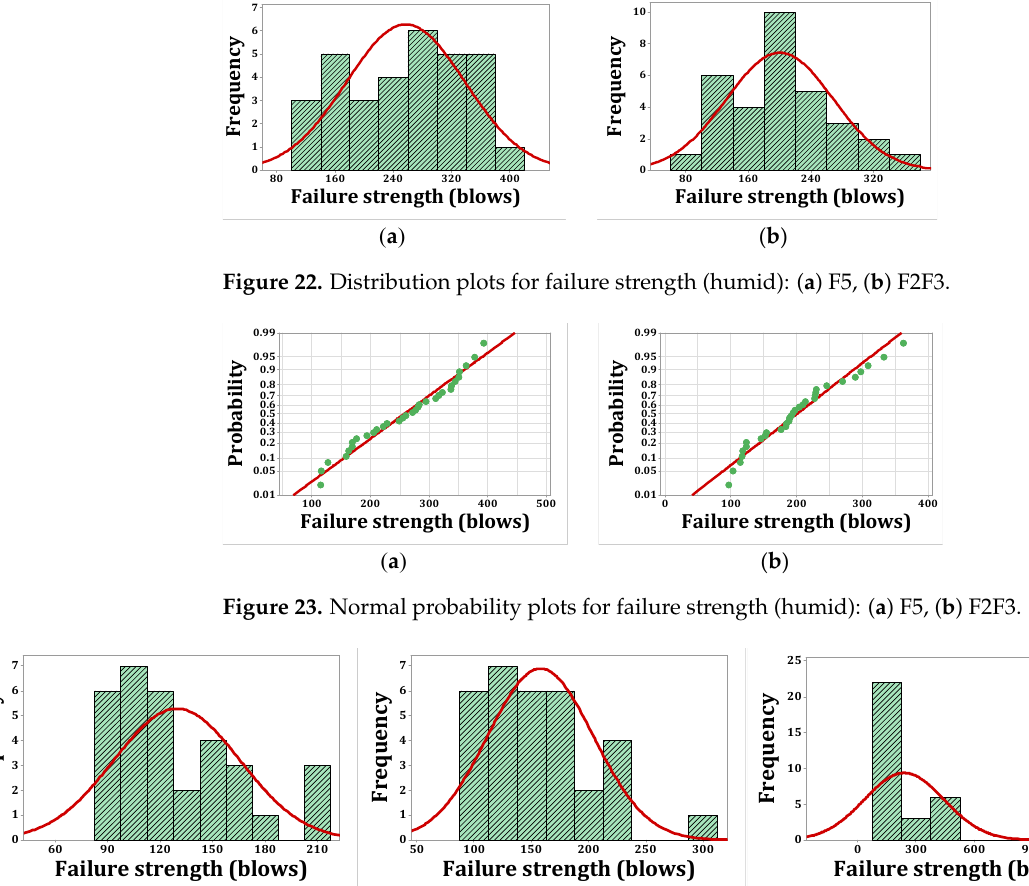
Figure 25. Normal probability plots for failure strength (dry): ( a ) R, ( b ) F2, ( c ) F3. ( b ) ) a ( Figure 26. Distribution plots for failure strength (dry): ( a ) F5, ( b ) F2F3. ( b ) ) a ( Figure 27. Normal probability plots for failure strength (dry): ( a ) F5, ( b ) F2F3. Figure 20a shows the frequency histogram with the normal plot, and Figure 21a shows the normal probability plot for the failure resistance R. Additionally, the p -value of the K–S test, which is equal to 0.068, is the result of a seldom normal distribution for this mixture. Figures 20b and 22a,b, which are related to mixtures of F2, F5, and F2F3, respec- tively, show a relatively close fit of the normal plot to the histogram. In addition, Figures 21b and 23a,b demonstrate the almost linear pattern of the mixed data. The p -value for mixtures F2, F5, and F2F3 by the K–S test indicates a number greater than 0.15, which confirms the normal distribution of these mixtures. For the F3 mixture, Figures 20c and 21c, plus the p -value (0.087), show that a normal distribution is rare. Reference concrete in a dry environment also rarely shows a normal distribution due to the poor display in Fig- ures 24a and 25a. The p -value for this mixture is equal to 0.075, which confirms its rarely normal distribution. The F2 mixture shows a normal distribution due to the relatively